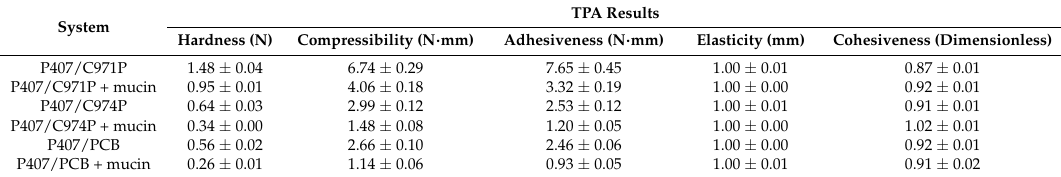
Table 6. Mechanical results obtained by texture profile analysis from the binary polymeric formulations composed of poloxamer 407 (P407) and Carbopol 971P ® (C971P), Carbopol 974P ® (C974P), or Noveon ® Polycarbophil (PCB) with or in the absence of mucin. Each value represents the mean ( ± standard deviation) of at least six replicates.